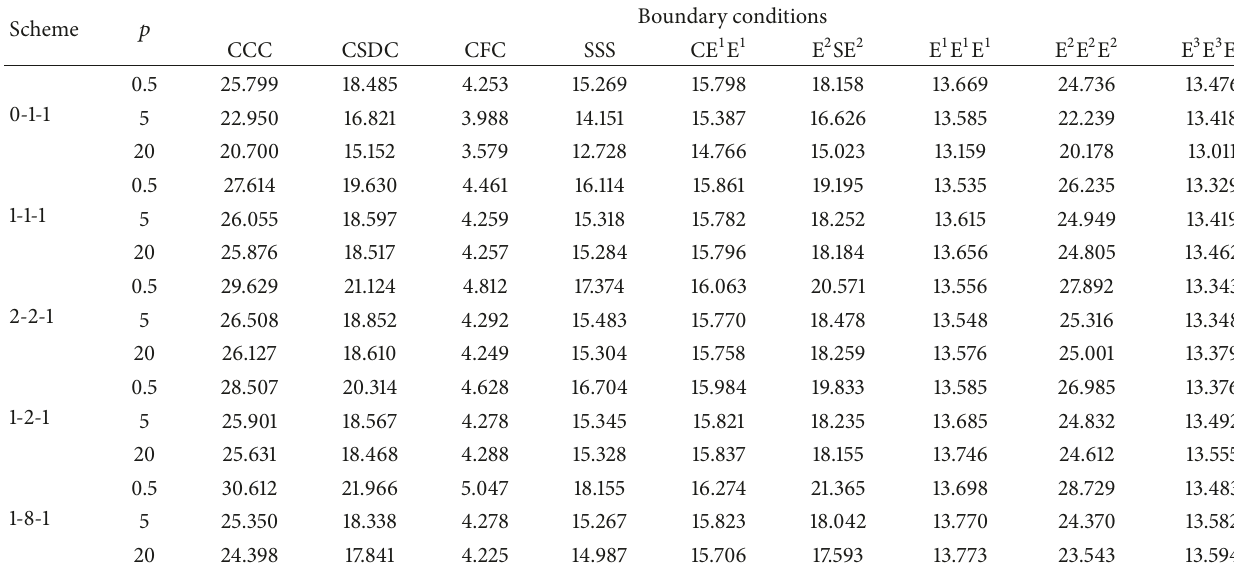
Table 11: Fundamental frequency parameter Ω for Type 2-1 circular sector plate with various boundary conditions ( ℎ/𝑅 1 = 0.2, 𝑝 2 = 𝑝 , and 𝜙 = 240 ∘ ).